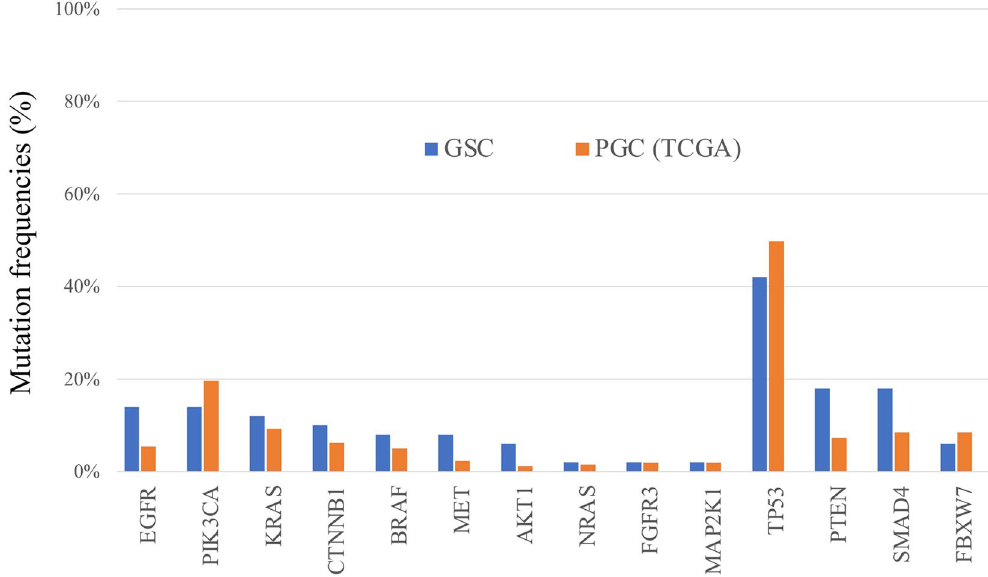
Figure 1. Comparison of gene mutation frequencies between GSC and PGC extracted from TCGA